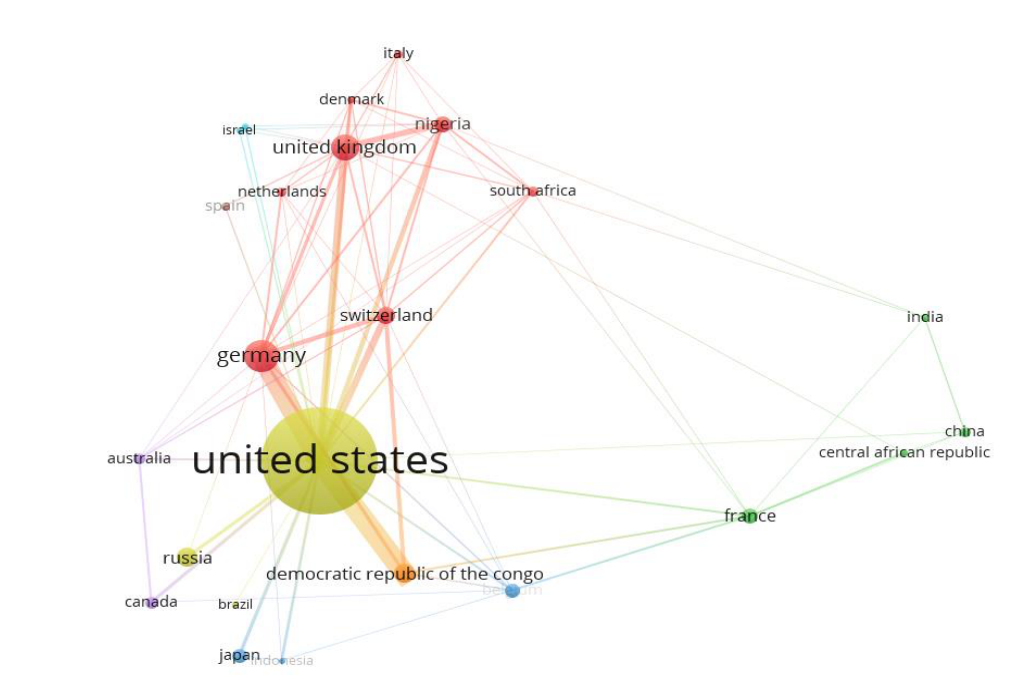
Figure 2 (a ). Bibliographic coupling of countries.